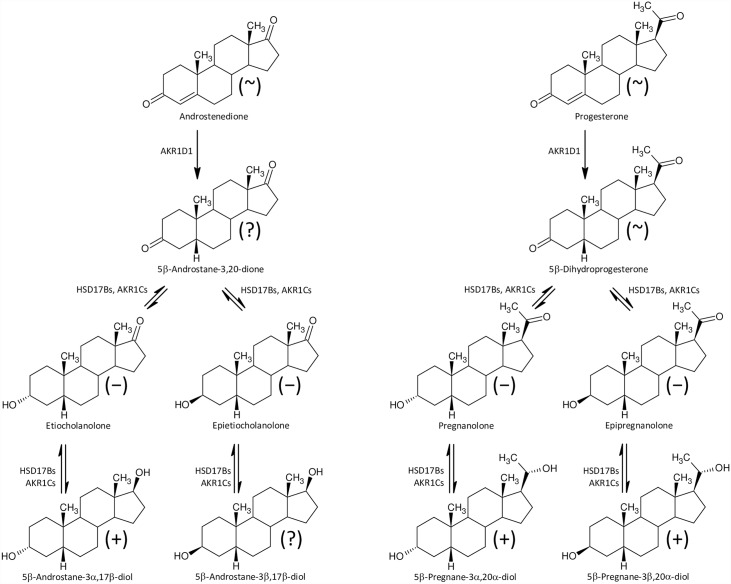
A simplified scheme of the biosynthesis of 5β-reduced C19 and C21 steroids in human.The symbols in parentheses “+”, “~”, ”−“, and ”?” represent increased, unchanged, decreased and unknown steroids levels, respectively, in the ICP group.